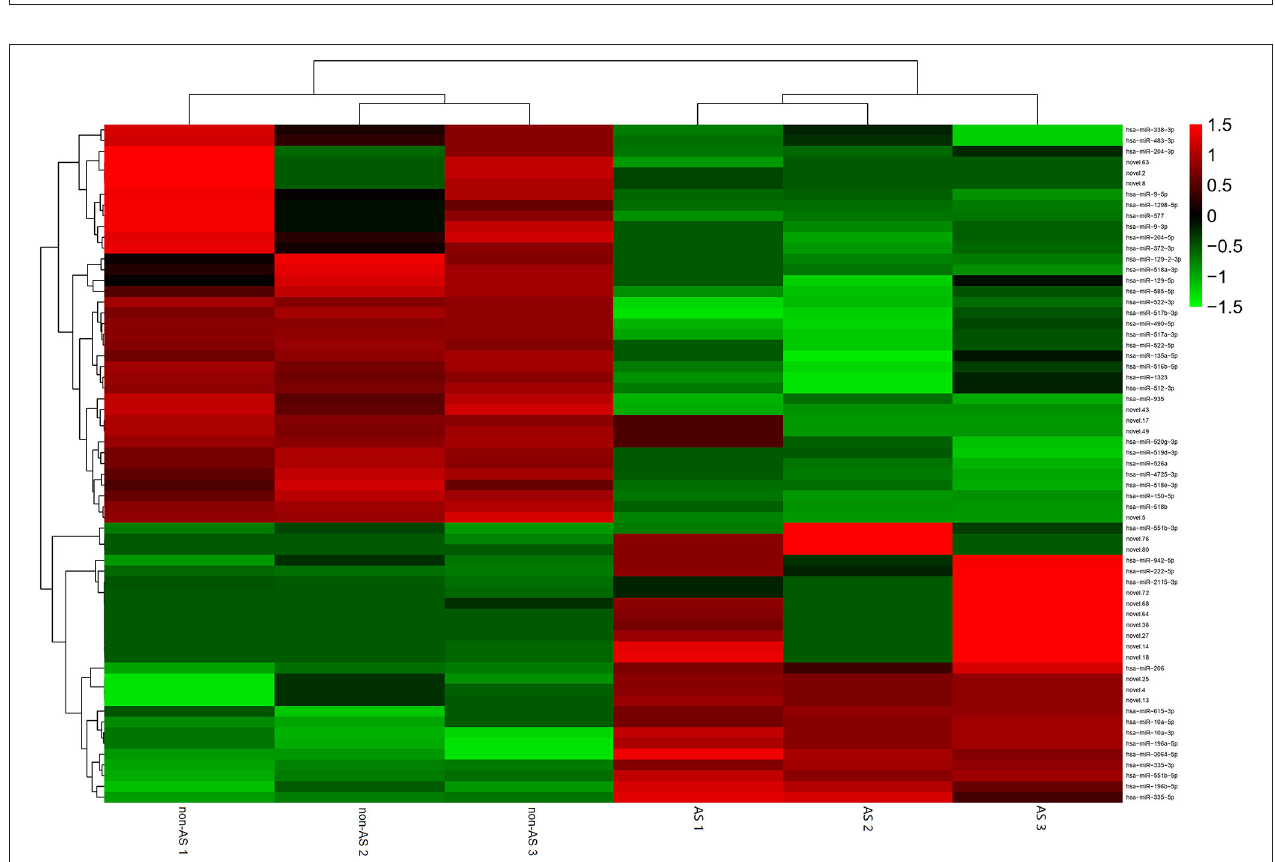
FIGURE 4 | Effect of EAT-derived exosomes on adipogenic differentiation of EASCs. Here the EASCs were derived from the EAT of CAHD patients. (A) The representative image of oil red O staining in non-AS group. (B) The representative image of oil red O staining in AS group. (C) Oil red O was extracted and absorbance was determined spectrophotometrically at 450nm to quantify adipogenic differentiation. non-AS: the group of EASCs intervened with the EAT-derived exosomes of non-CAHD patients. AS: the group of EASCs intervened with the EAT-derived exosomes of CAHD patients. Data are presented as the means ± standard error of the mean for six independent experiments. * P < 0.05 vs. non-AS.